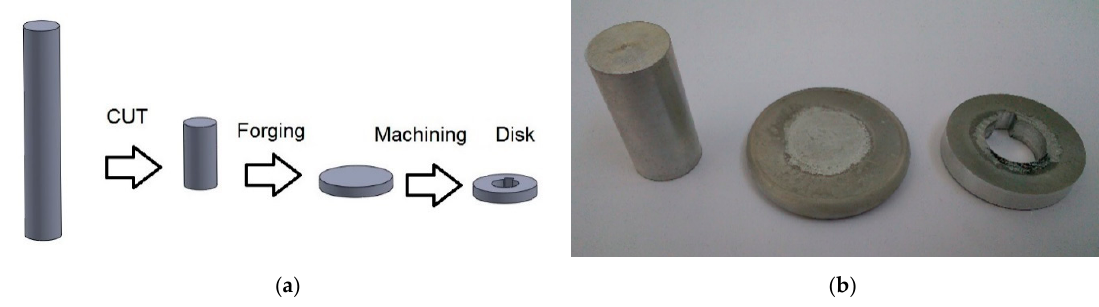
Figure 3. Steps for the manufacturing process of the disks ( a ) and test disks finally manufactured ( b